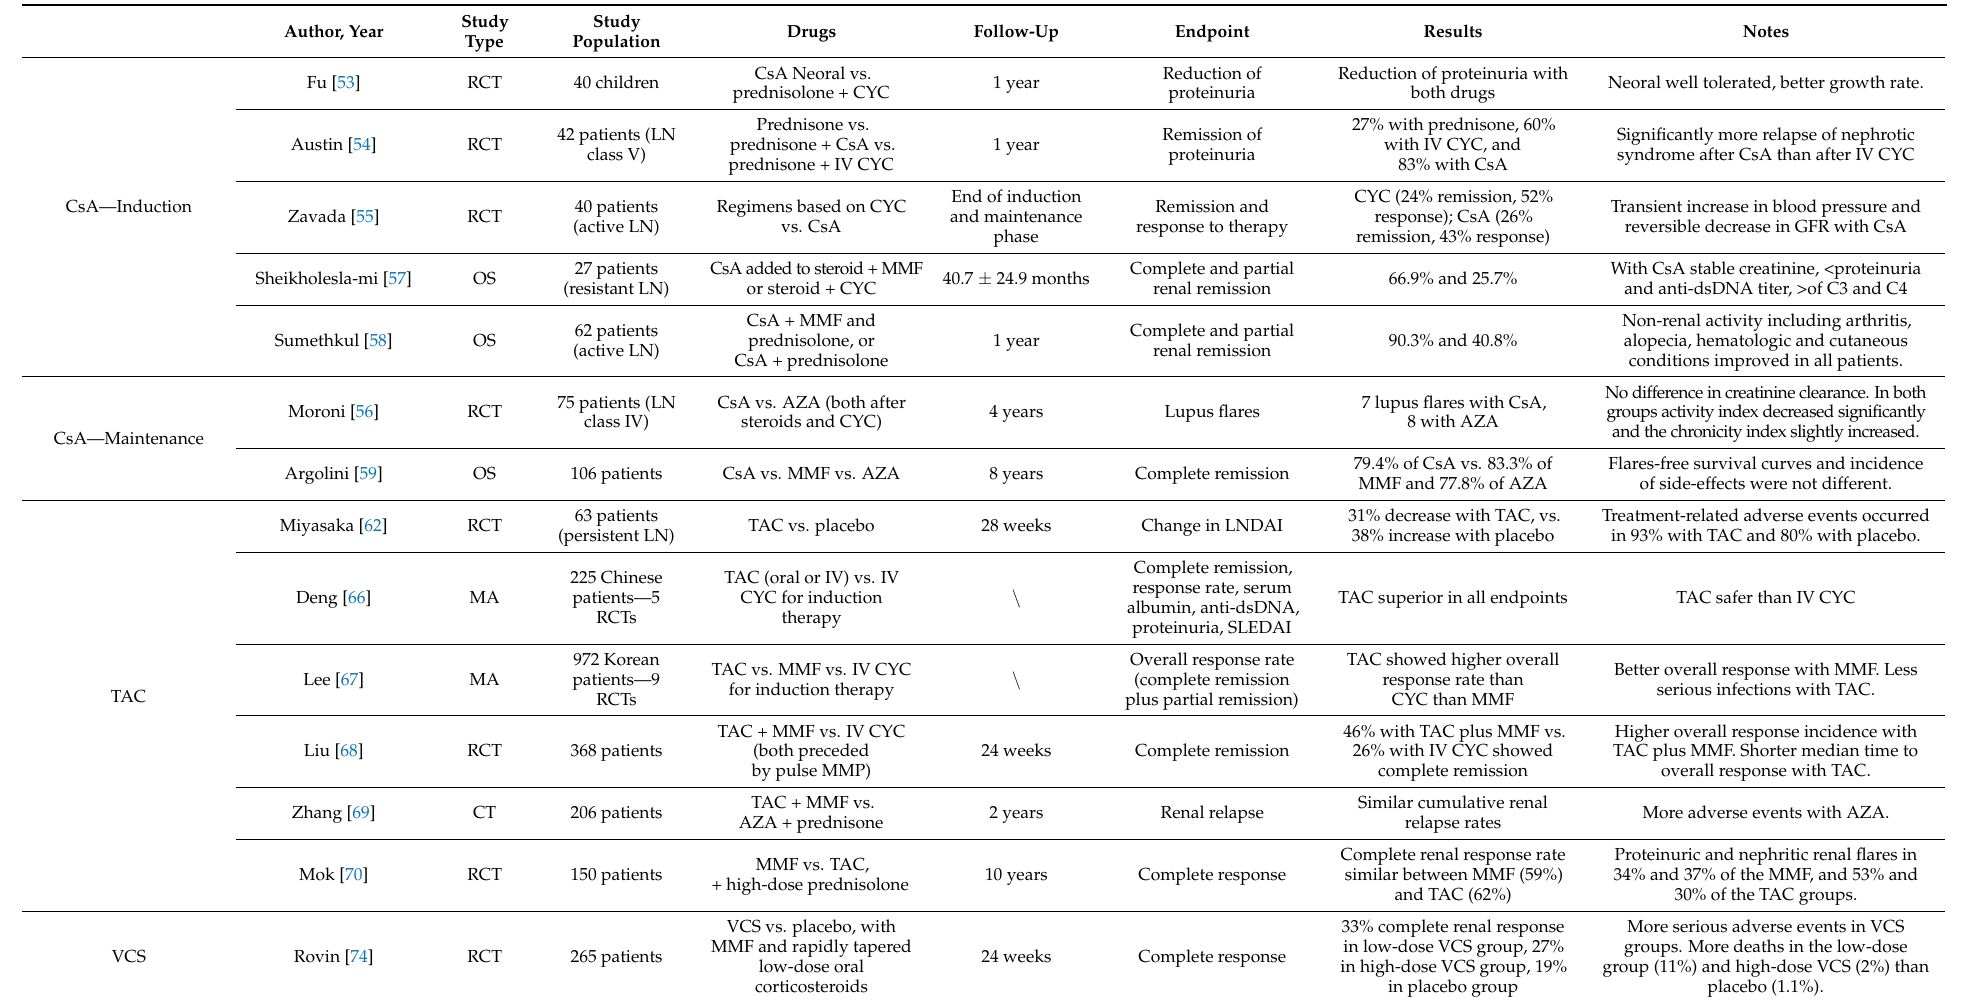
Table 4. Summary of the main studies regarding the use of CNIs in lupus